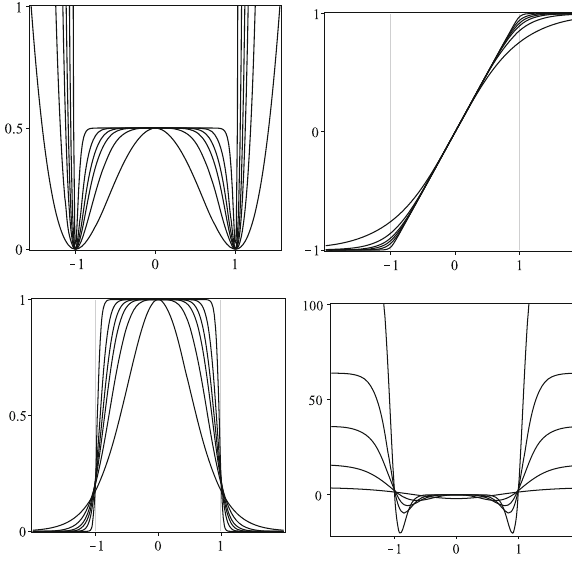
Fig. 1 The potential (12) (top left), its corresponding kinklike solution (top right), energy density (bottom left) and stability potential (bottom right), depicted for n = 1 and for several other higher values of n